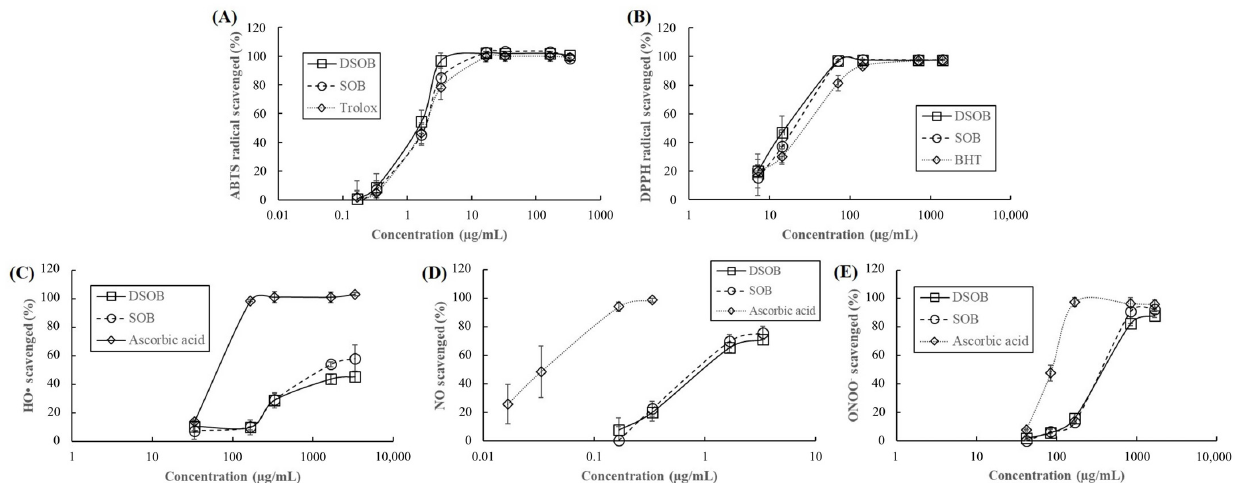
Figure 2. Antioxidant capacities of defatted seeds of Oenothera biennis (DSOB) and seeds of Oenothera biennis (SOB). ( A ) 2,2-Azinobis(3-ethylbenzothiazoline-6-sulfonic acid) diammonium salt (ABTS) radical scavenging activity of DSOB, SOB, and Trolox (positive control). ( B ) 1,1-Diphenyl-2-picrylhydrazyl (DPPH) radical scavenging activity of DSOB, SOB, and 2,6-di-tert-butyl-4-methylphenol (BHT, positive control). ( C ) Hydroxyl radical (HO•) scavenging activity of DSOB, SOB, and ascorbic acid (positive control). ( D ) Nitric oxide (NO) scavenging activity of DSOB, SOB, and ascorbic acid (positive control). ( E ) Peroxynitrite (ONOO − ) scavenging of DSOB, SOB, and ascorbic acid (positive control).